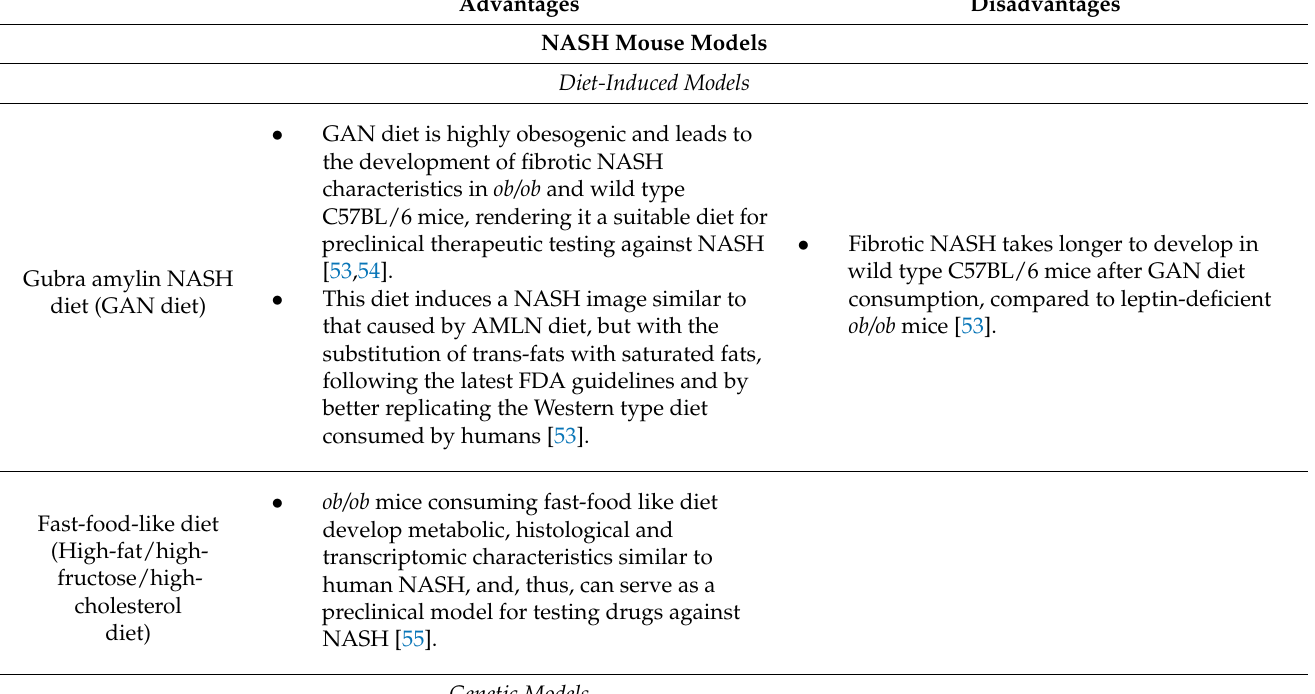
Table 1. Cont . Advantages Disadvantages NASH Mouse Models Diet-Induced